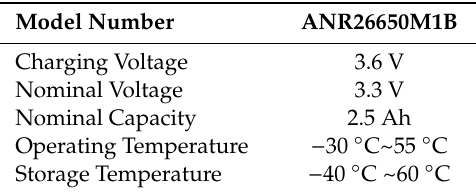
Table 2. Specification of cell, (Company: A123 System LiFePO 4 ).